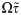
(a) Values of the arcsine function and (b) an example for transformation of ΩΔτ and Ωτ˜.(a) Blue for arcsin(x) ∈ [−π/2, π/2] and red for arcsin(x) ∈ [π/2, 3π/2] in the Cartesian plane. (b) Values of Ωτ1,2 (black) and ΩΔτ and Ωτ˜ (red), and ΩΔτ* = ΩΔτ ± π and Ωτ˜*=Ωτ˜±π (blue), which appear due to the summation sin(Ωτ1 + ϕi) + sin(Ωτ2 + ϕi + 2π).